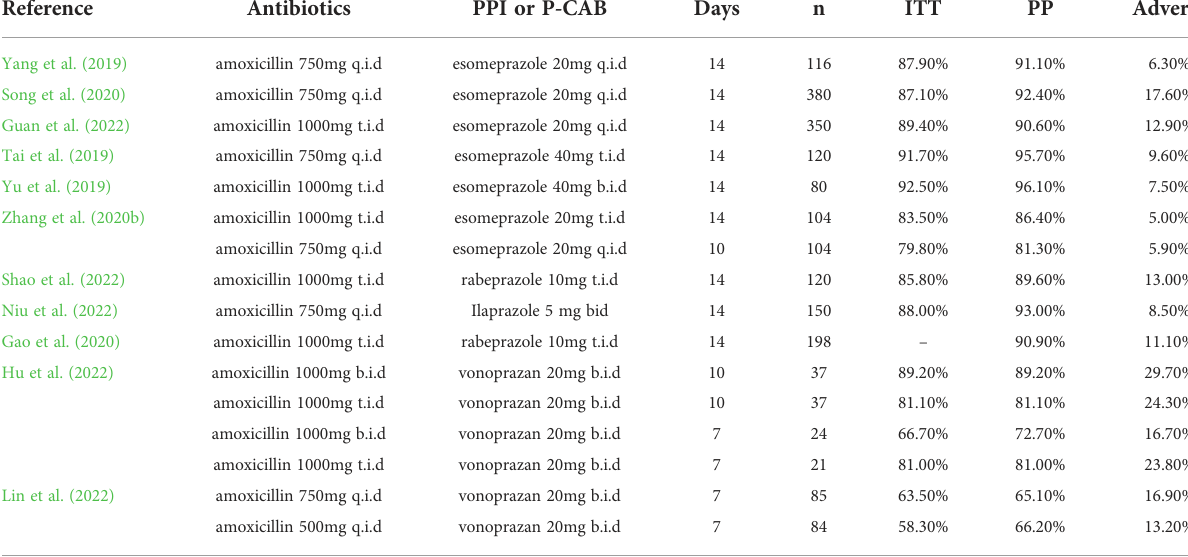
TABLE 1 Summary of HDDT or VA dual therapy as the fi rst-line treatment of H. pylori infection in